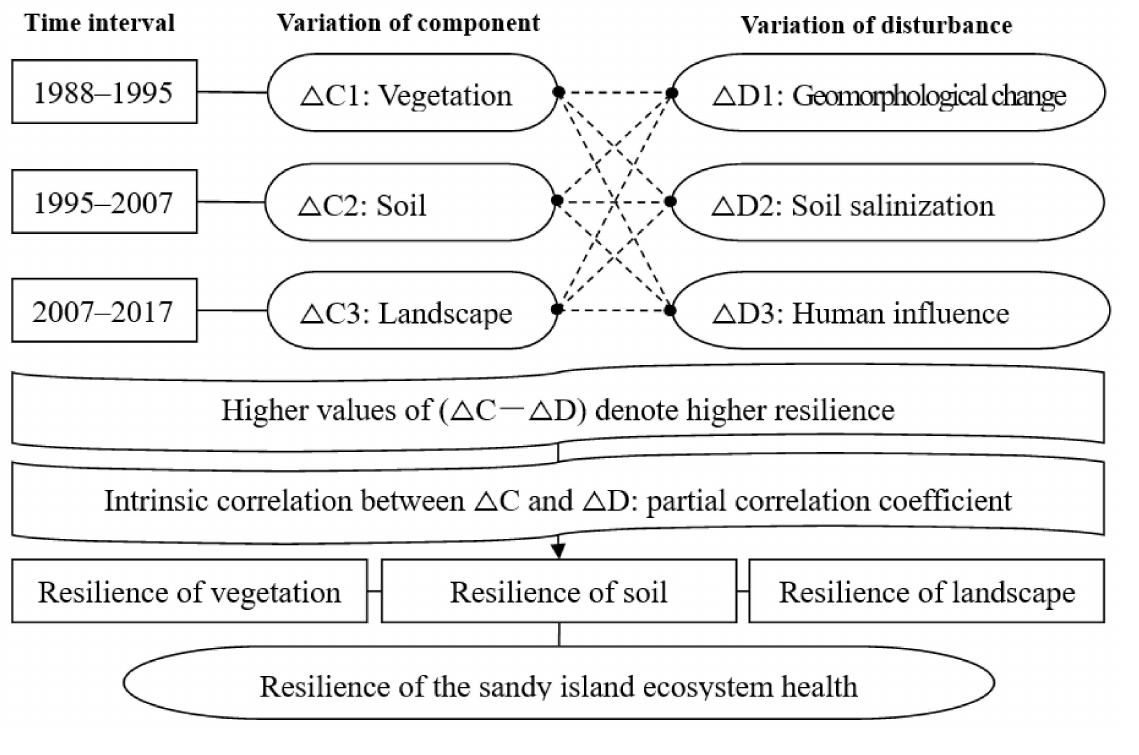
Figure 4. Framework for assessing the resilience of the sandy island ecosystem health: ∆ C and ∆ D indicate the variations of a component and disturbance, respectively, across a time